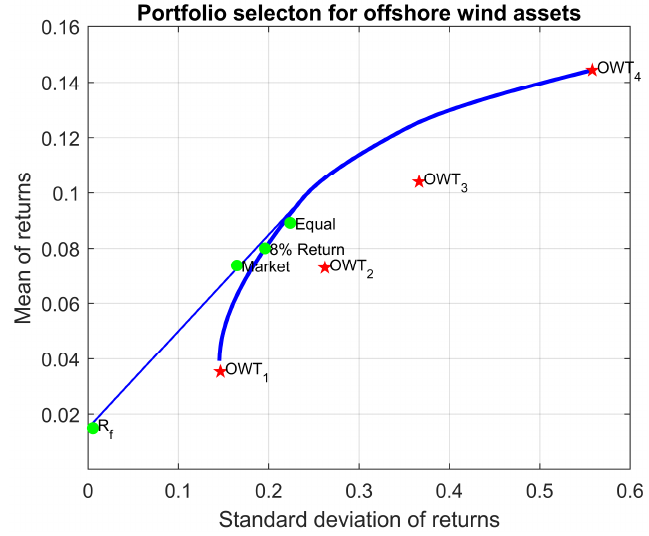
Figure 11. Mean value of ROI as a function of standard deviation, 8% return and equal weights.